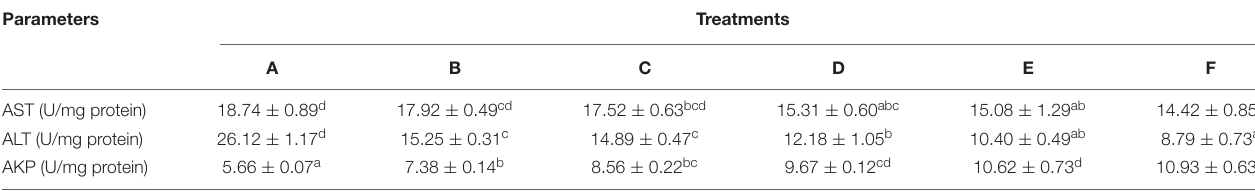
TABLE 7 | Hemolymph-immunological parameters of P. monodon fed with experimental diets. #